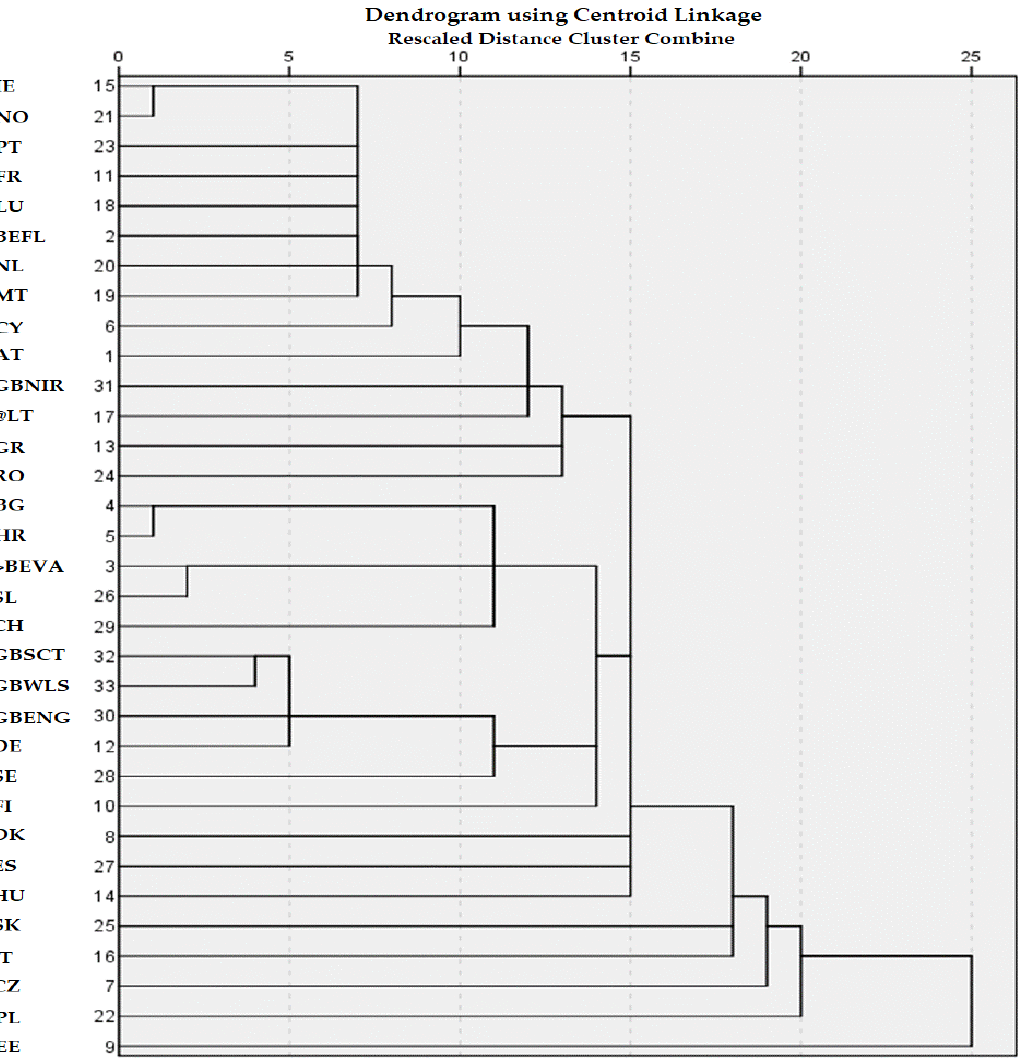
Figure 1. Results of cluster analysis of different EU member states based on their school feeding policy. Source: Authors’ own construction, based on EU [28]